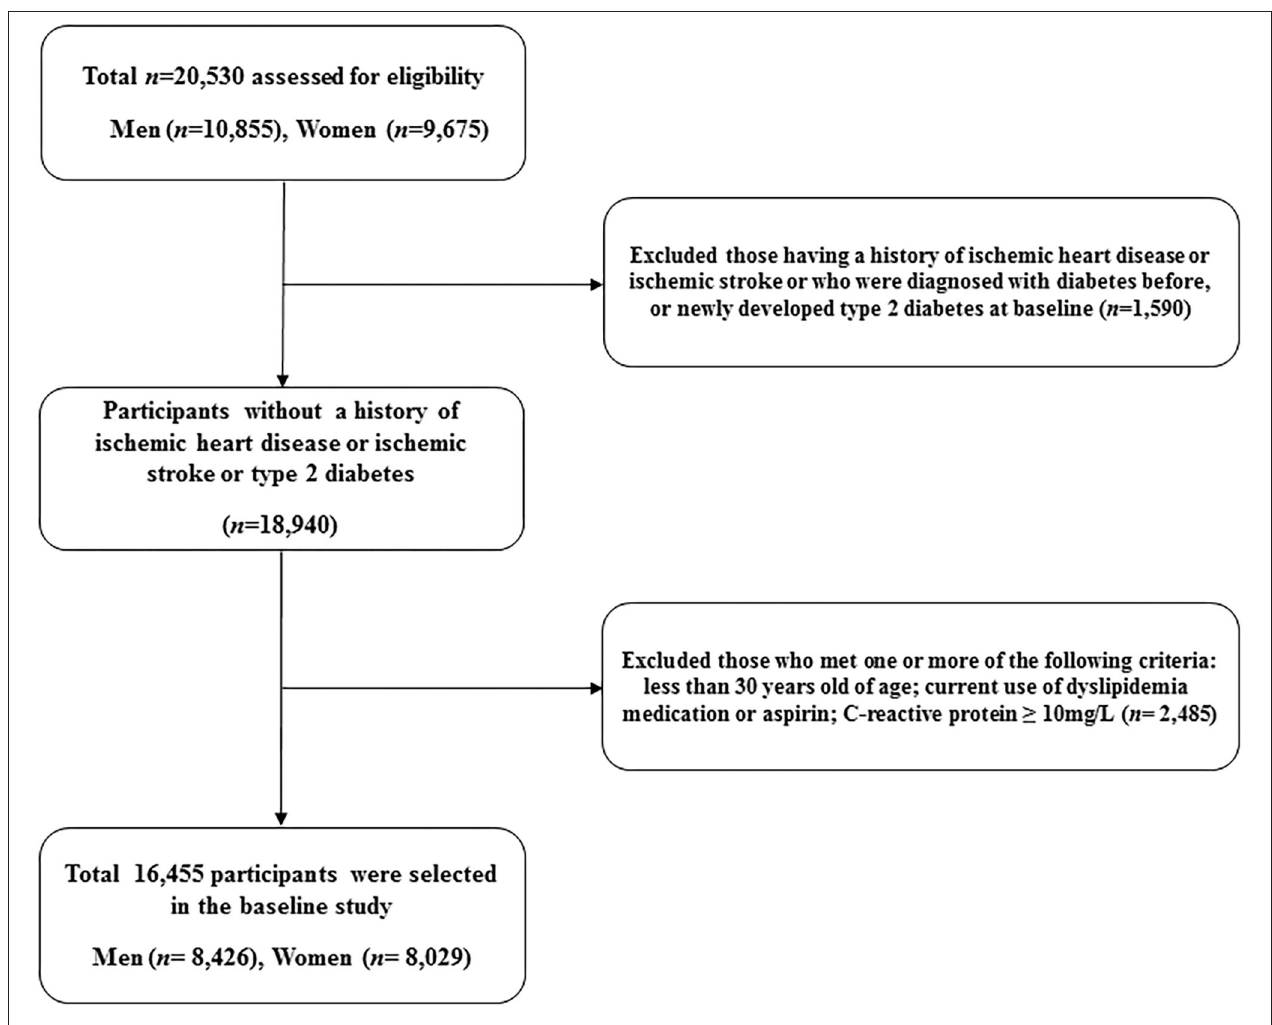
FIGURE 1 | Flowchart for the selection of study